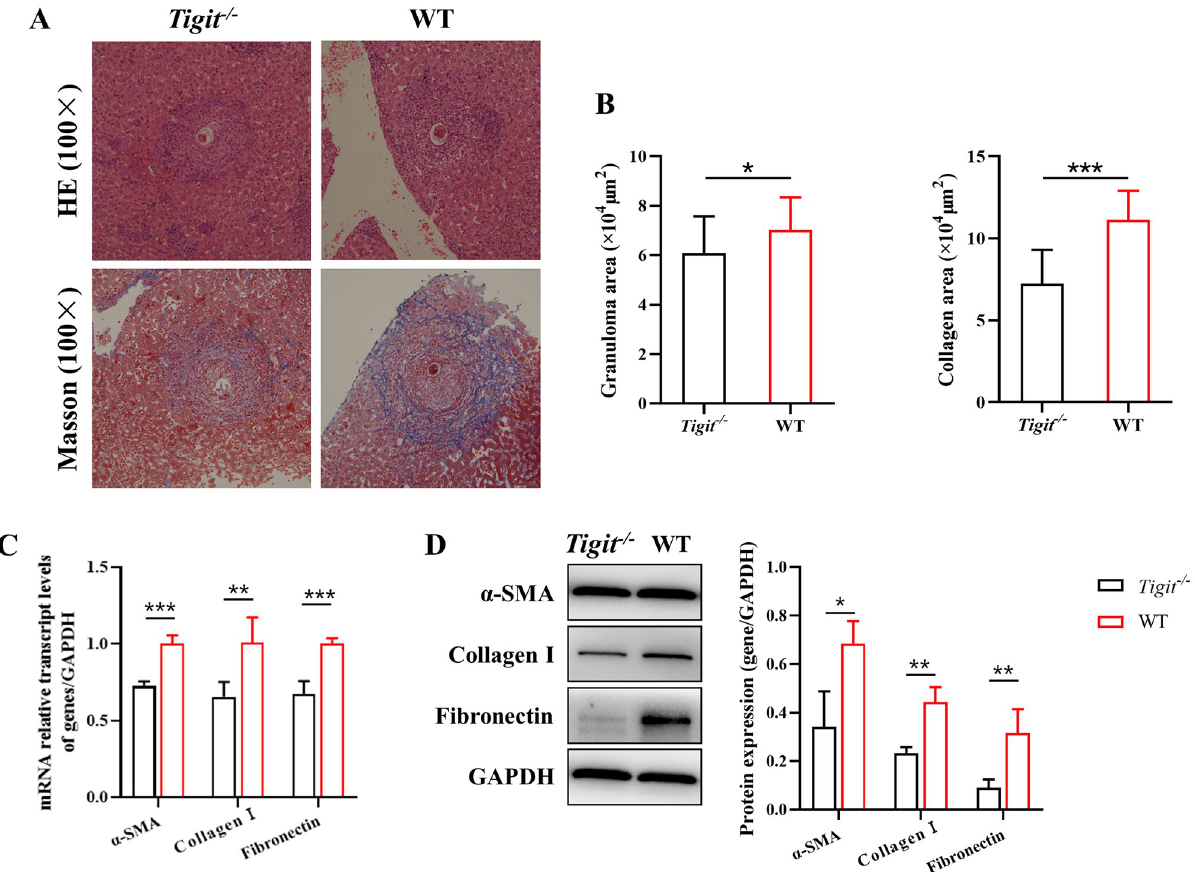
Fig 5. Tigit knockout reduces the degree of liver fibrosis in schistosomiasis. (A) Liver tissues of Tigit -/- and wild-type (WT) mice were stained with hematoxylin-eosin (HE) and Masson trichome at 6 weeks post infection. (B) Liver granuloma and collagen area at 6 weeks post infection in Tigit -/- and WT mice. (C) Relative mRNA transcript levels of α -SMA, collagen-I, and fibronectin in Tigit -/- and WT mice at 6 weeks post infection. (D) Protein expression levels of α -SMA, collagen-I, and fibronectin in Tigit -/- and WT mice at 6 weeks post infection. All data are presented as mean ± standard deviation of at least three independent experiments. � P < 0.05, �� P < 0.01, ��� P < 0.001.